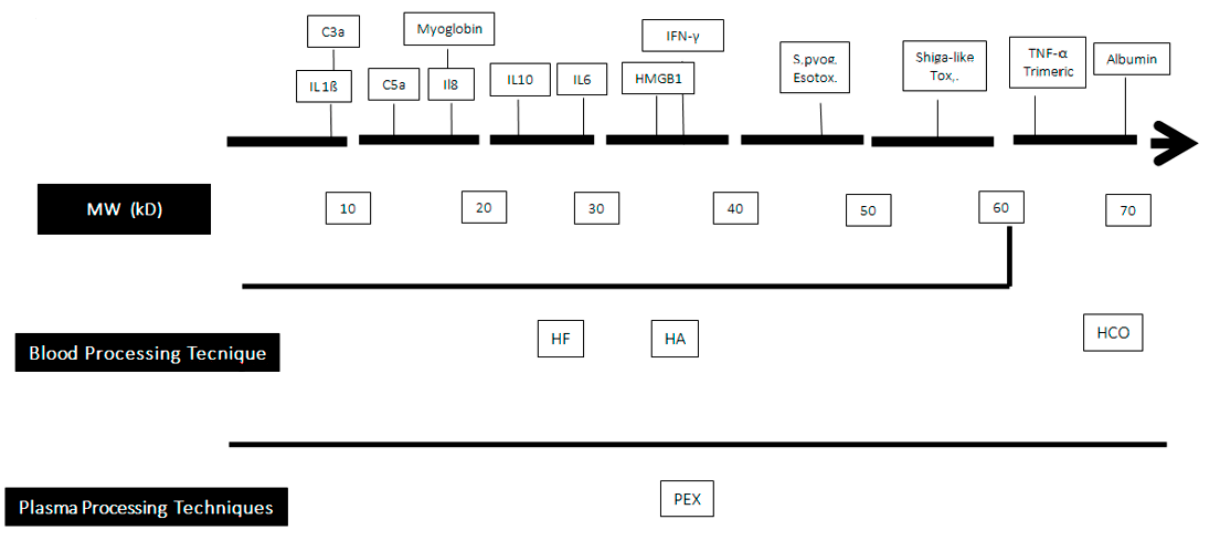
Figure 1. Clearance capabilities of blood purification techniques according to the molecular weight of some bloodborne substances. MW: Molecular Weight; HF: Hemofiltration; HA: hemadsorption; PEX: plasma exchange; HCO: high cut-off membrance.C3a: Activated Complement factor 3; IL: interleukin; HMG 1: High Mobility Group Box 1; IFN- γ : γ Interferon.